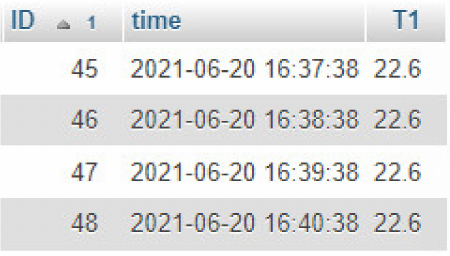
Figure 5. Temperature readings from MySQL.